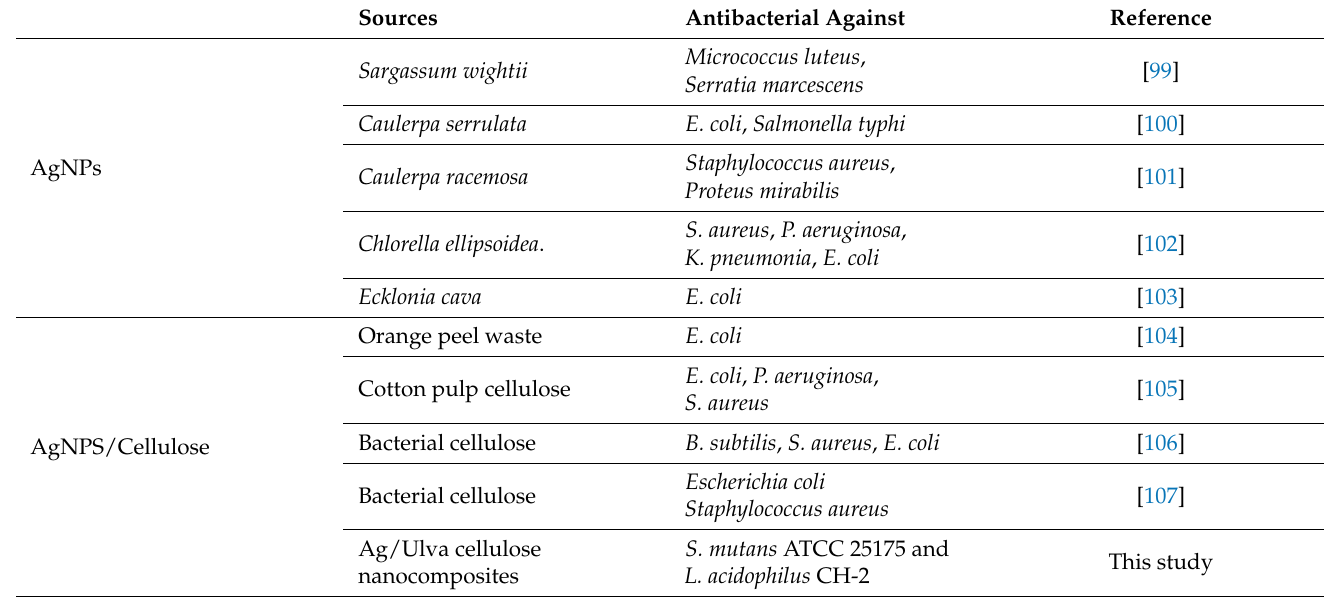
Table 6. Comparison study with other researches on antibacterial